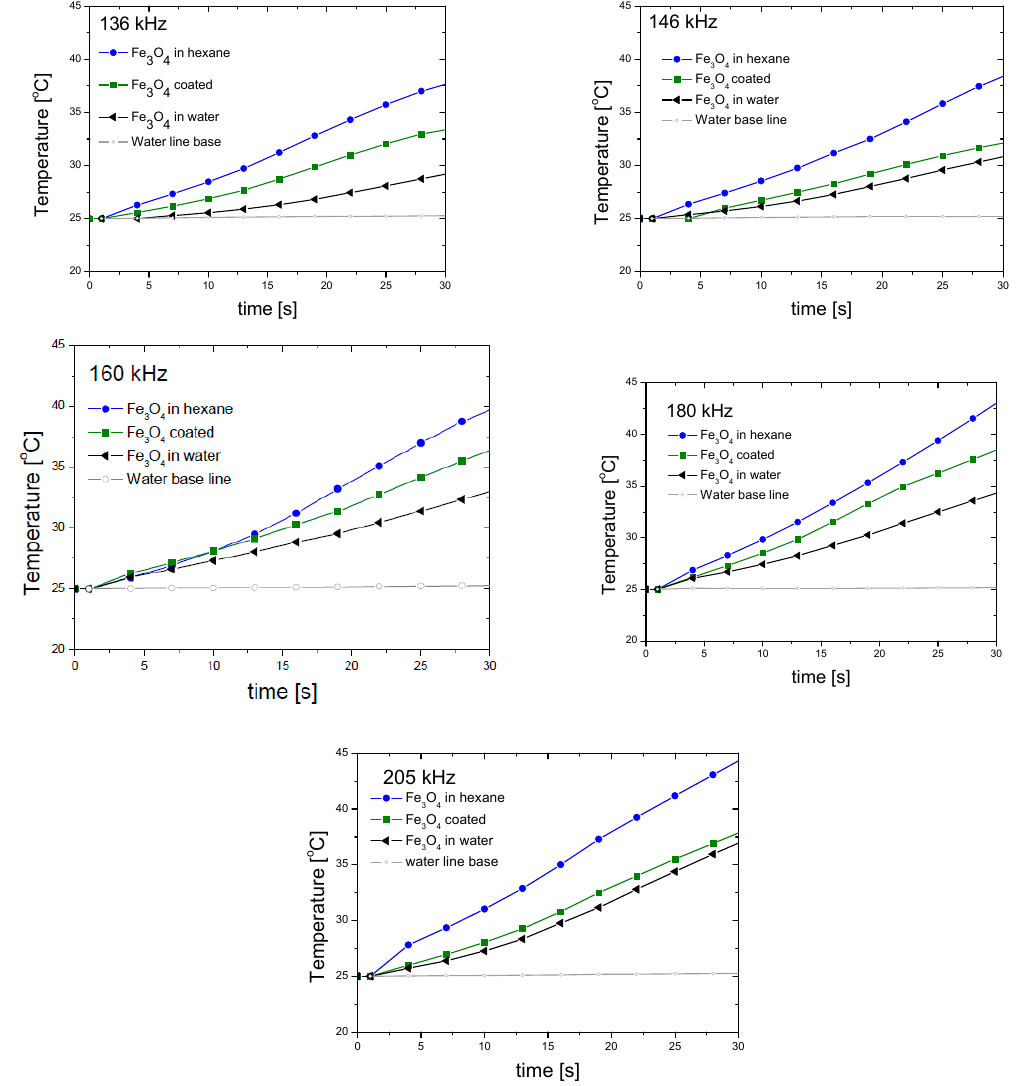
Figure 12. Heating curves for Fe 3 O 4 nanoparticles in water and hexane before and after coating with PDMAEMA, measured at different frequencies.